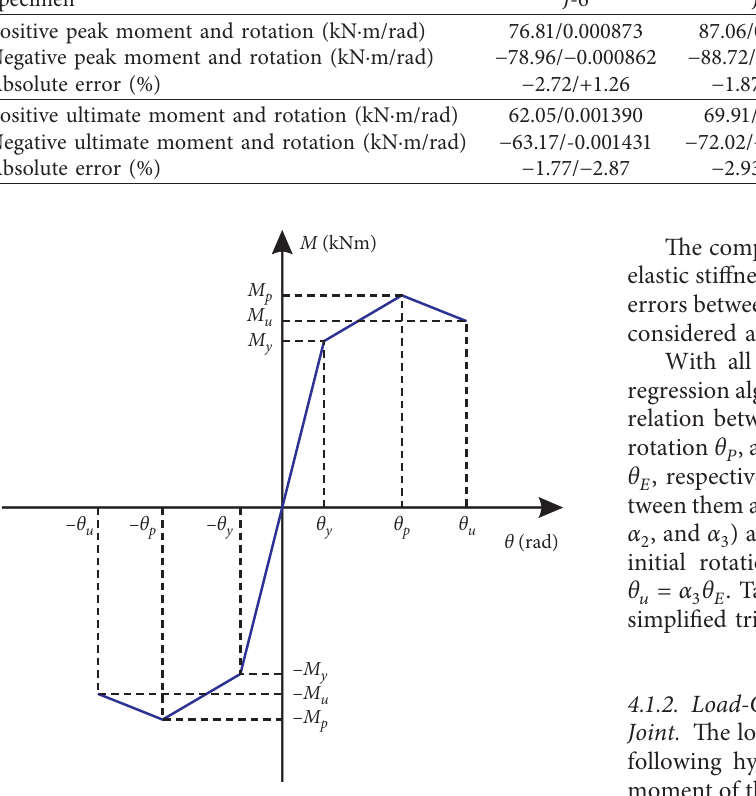
Figure 4: The simplified trilinear skeleton curve proposed in this work.